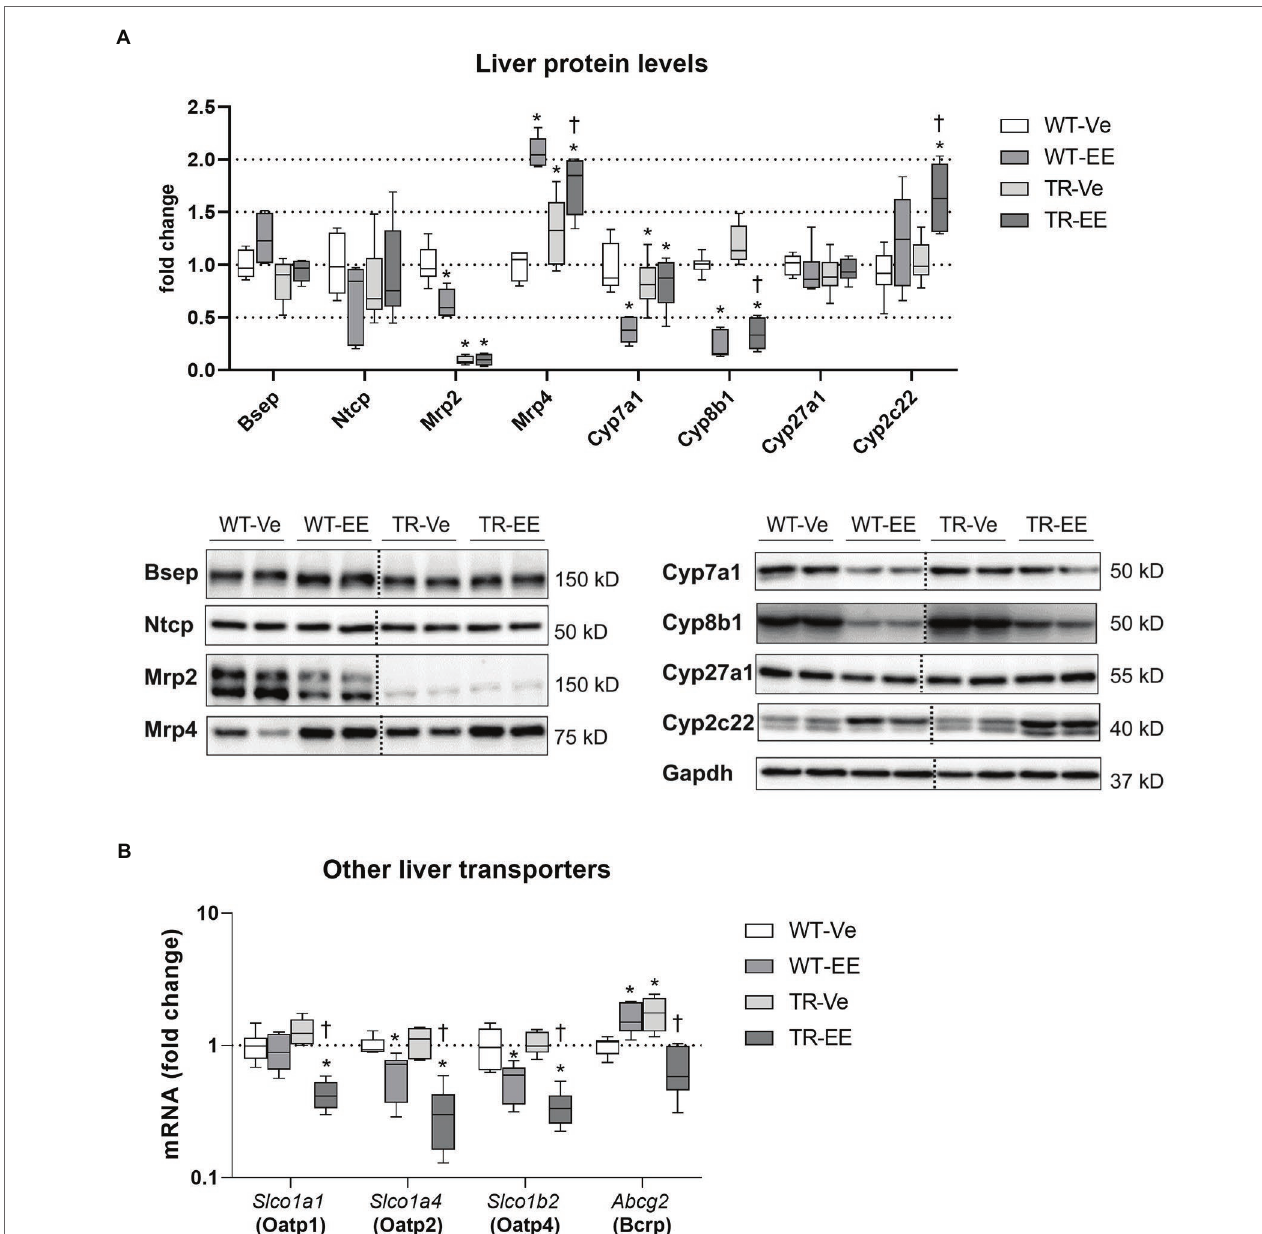
FIGURE 6 | Effect of ethinylestradiol and Mrp2 deficiency on the mRNA and protein expression of bile acid-related genes in the liver. Experimental groups: WT-Ve, WT rats receiving vehicle; WT-EE, WT rats receiving ethinylestradiol; TR-Ve, TR rats receiving vehicle; and TR-EE, TR rats receiving ethinylestradiol. (A) The protein expression of crucial bile acid synthetizing and transporting molecules in the liver. Dotted line shows where irrelevant bands were omitted. (B) The gene expression of alternative hepatocyte transporters for bile acids. Protein and mRNA levels were normalized to Gapdh expression. Data are presented as medians, with boxes and whiskers representing the interquartile range and 5th-95th percentiles, respectively. Protein and mRNA levels were normalized to Gapdh expression. Significance: * p < 0.05, compared to vehicle-treated WT rats; † p < 0.05 compared to vehicle- treated TR